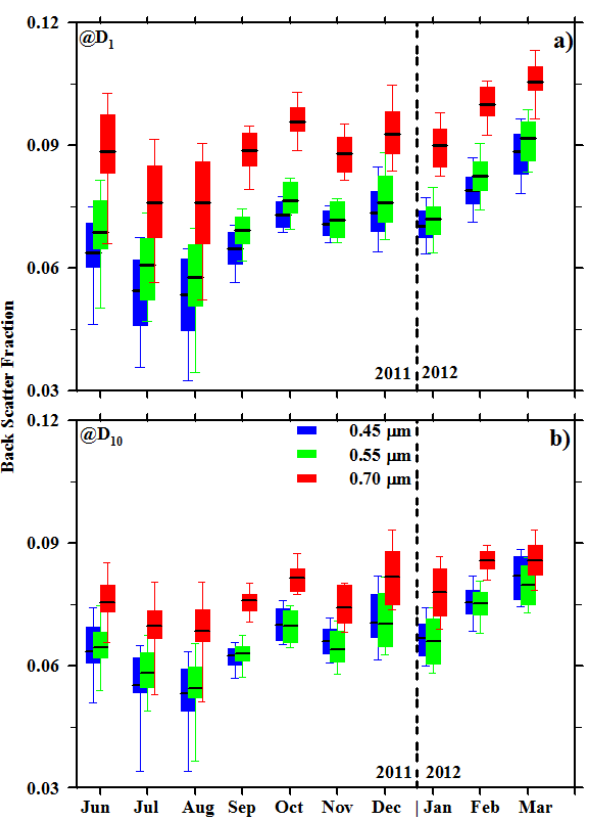
Figure 5. Same as in Fig. 2 but for the back-scatter fraction. Figure 6. Same as in Fig. 2 but for the submicron absorption (a) and scattering (b)